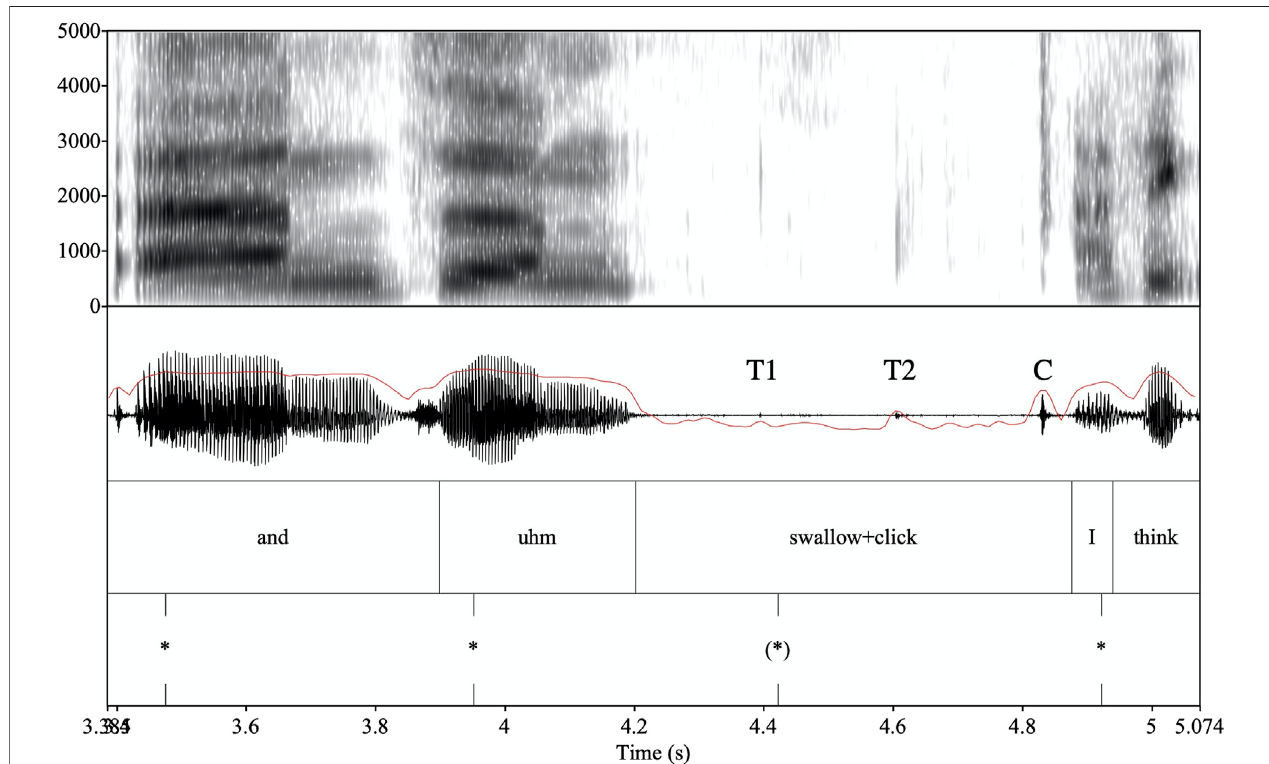
FIGURE 1 | Spectrogram and waveform of a swallow + click combination from Example 1 . T1 and T2: transients relating to phases of swallowing. C: click sound on release of the swallow.